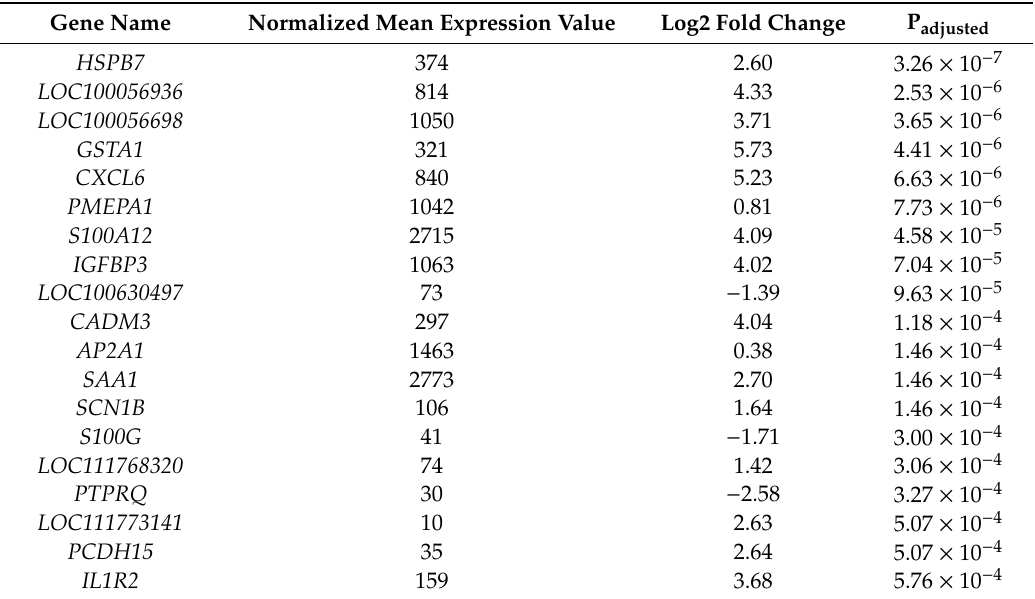
Table 8. Top 20 significantly di ff erentially expressed genes between asthmatic horses in exacerbation and healthy horses according to the P adjusted . The normalized mean expression values calculated by DESeq2, the log2 fold change, as well as the adjusted p -values are